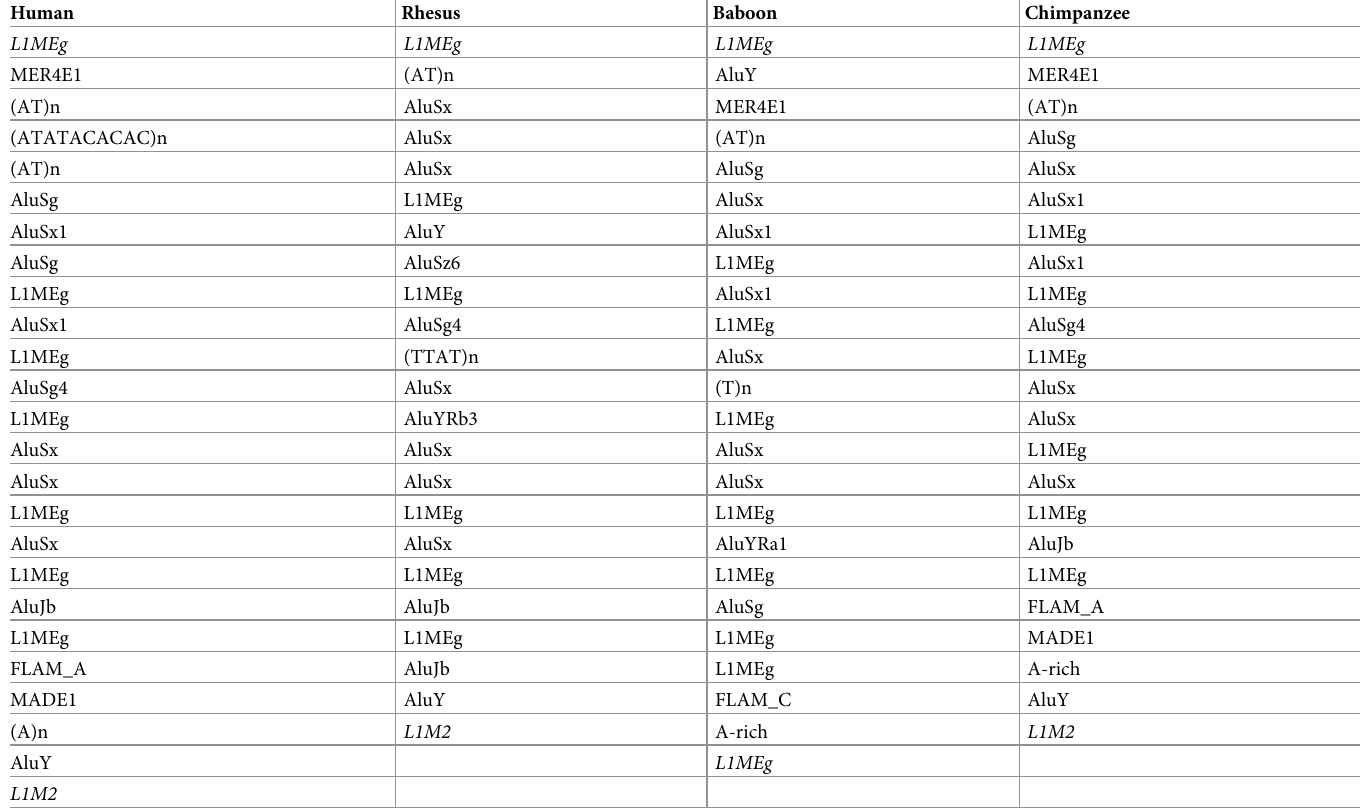
Table 2. Alu/LINE TE tandem arrays in BCRP3 sequences of primates �